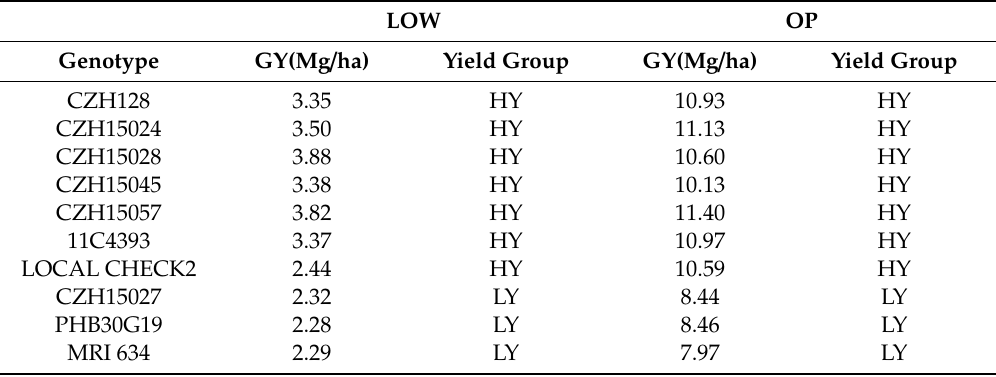
Table 2. Maize genotypes that were in both, the HY and LY groups with different applications of nitrogen: LOW and OP, with their GY.